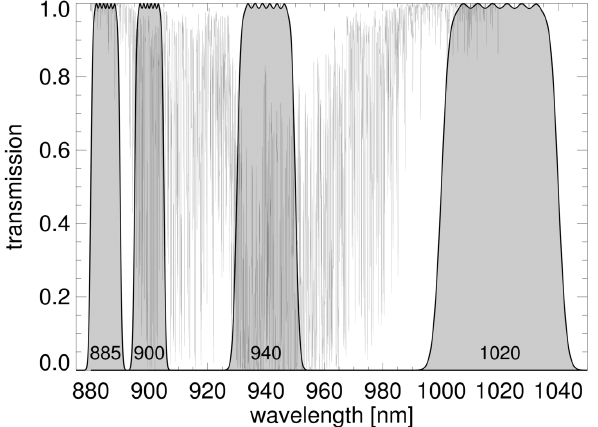
Fig. 1. OLCI channel constellation in the NIR (normalized response functions) and total transmittance of the atmosphere in ρστ -band.